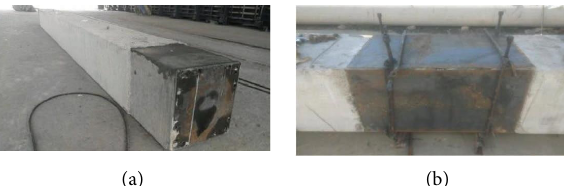
Figure 2: Scene diagram of precast concrete square pile. (a) Precast concrete square pile. (b) Precast concrete square connection